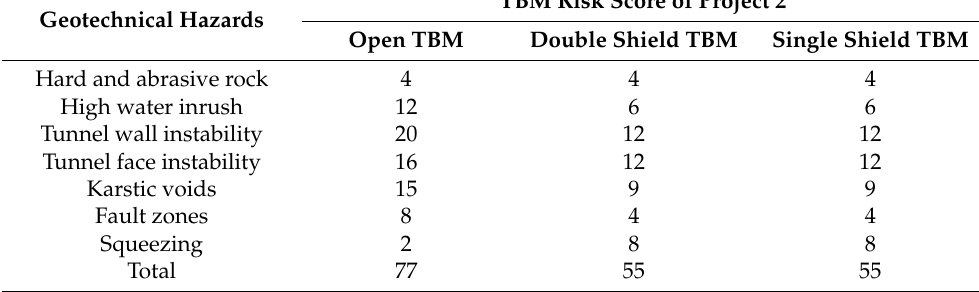
Table 23. TBM risk score of Project 2.